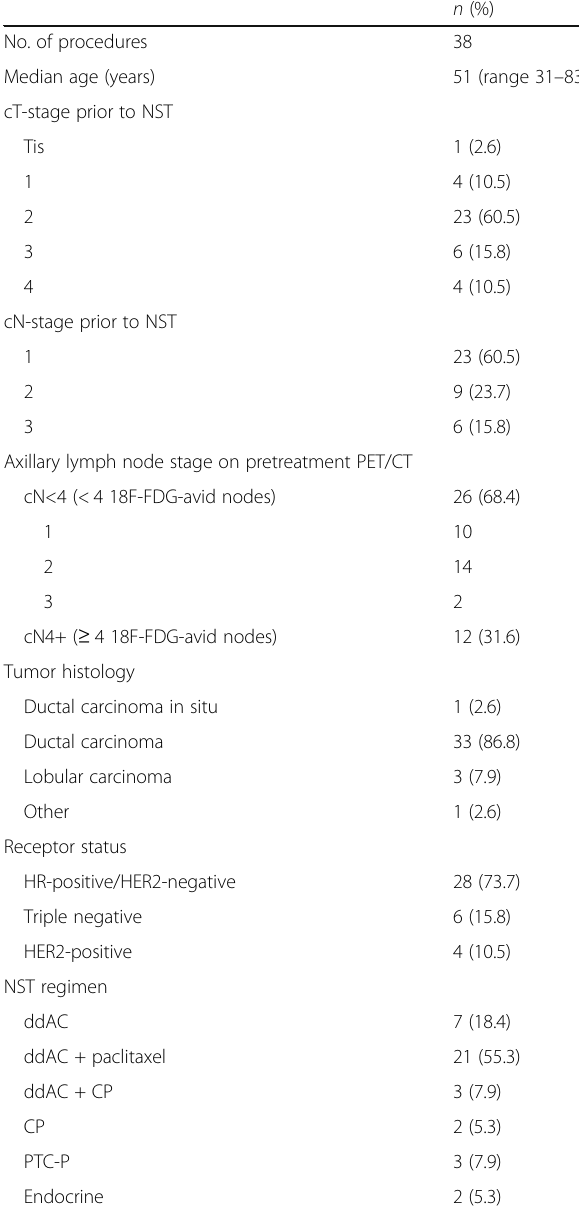
Table 1 Patient and tumor